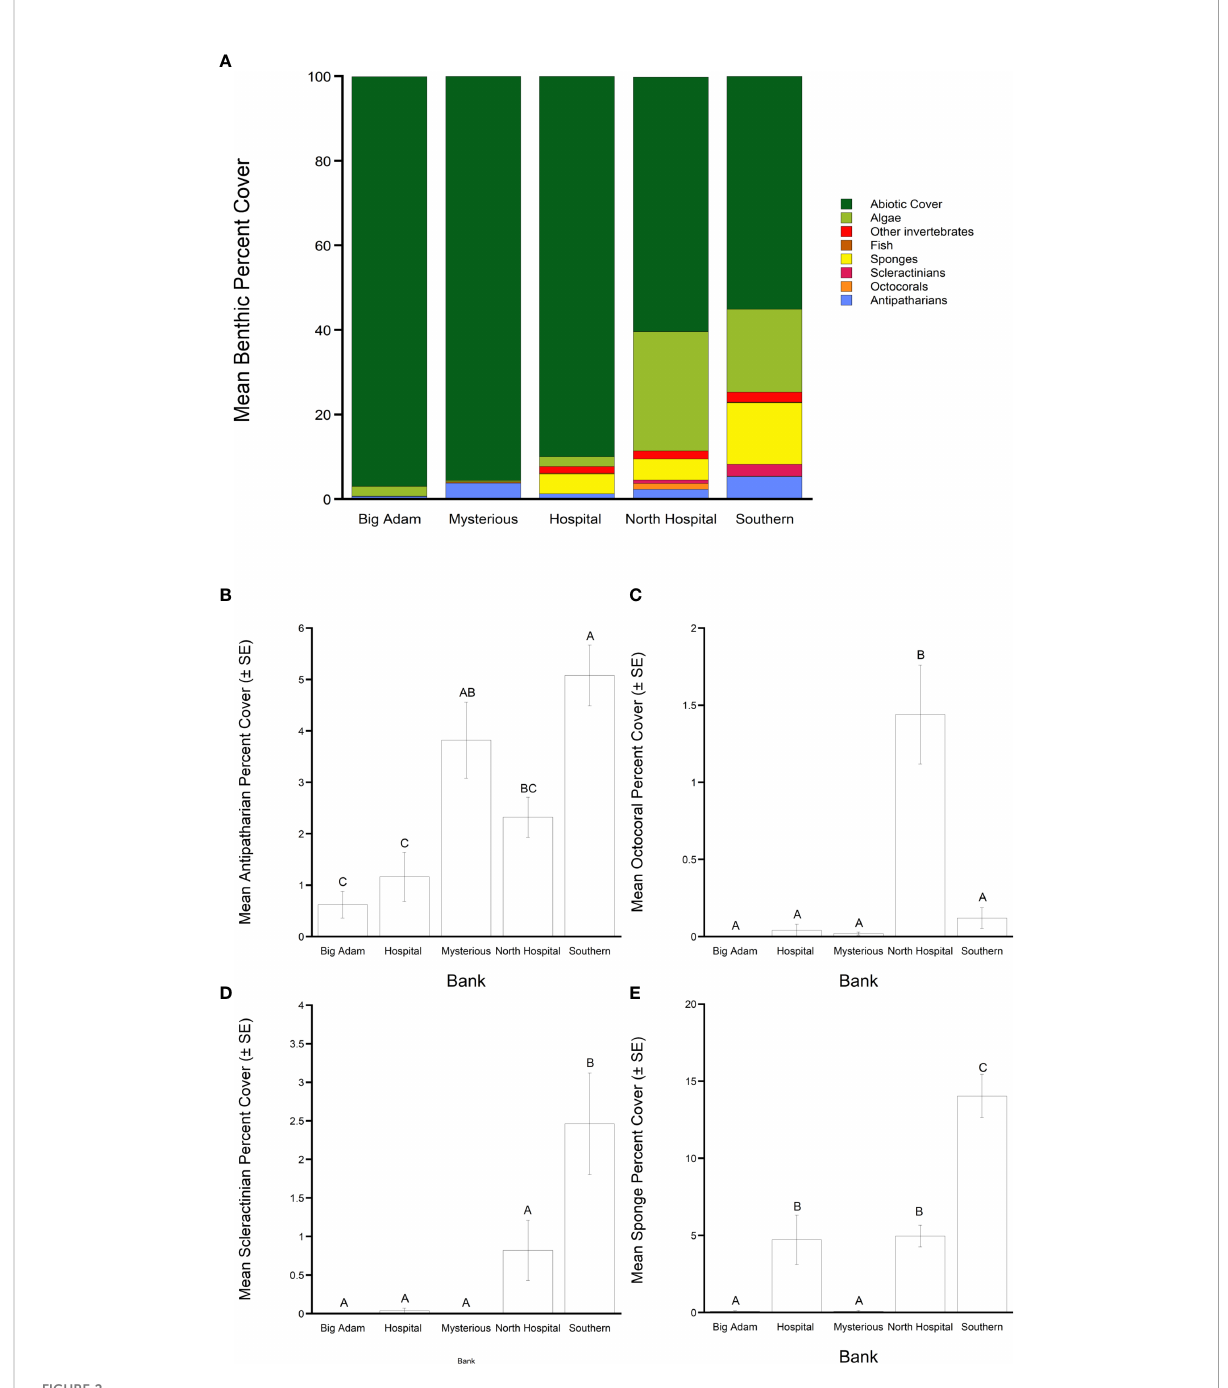
North Hospital Banks had intermediate mean cover (3.82% and 2.32% respectively), and Hospital and Big Adam Banks had the lowest mean cover of antipatharians (1.16% and 0.62% respectively) (Tukey ’ s HSD: P<0.05) (Figure